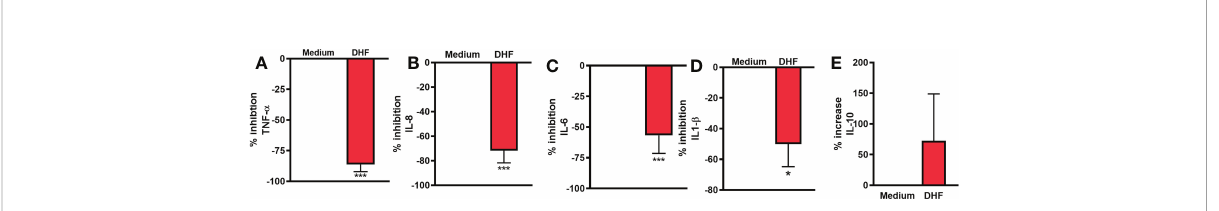
FIGURE 6 Anti-in fl ammatory effect of DHF on esophageal biopsy sample: Esophageal biopsy samples were cultured with or without DHF for 24 hrs. and cytokine levels in the culture supernatant were measured by ELISA. Percentage inhibition of cytokines TNF- a (A) , IL-8 (B) , IL-6 (C) , IL1- b (D) and percentage of increase in cytokine IL-10 (E) in presence of DHF were analyzed. Data represents Mean ± SEM. N=6-8 samples. ***p < 0.001; *p < 0.05 compared to Medium. Paired t test was used for statistical analysis.